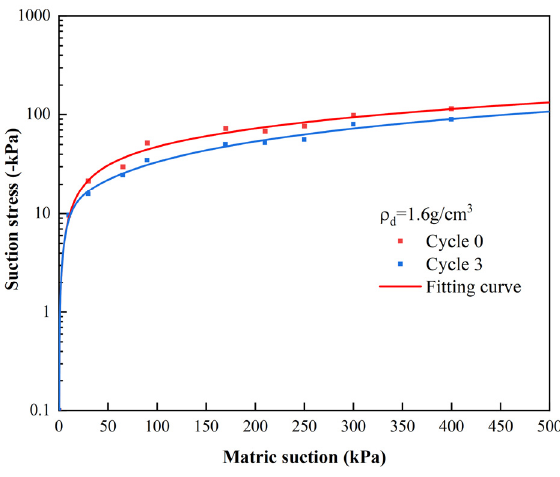
Figure 9. (cid:2025) (cid:3031) =1.6 g/cm³ loess sample SSCC fitted by the modified